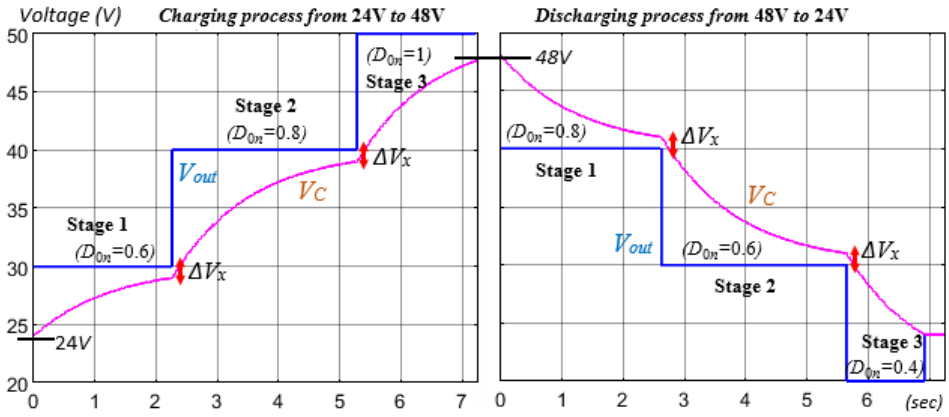
Figure 9. Voltage variations during charging/discharging in the case of five phases with ∆ V x = 1 V.